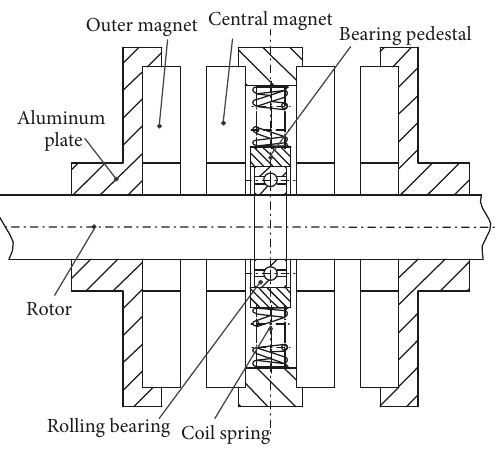
Figure 3: Structure of the NES.